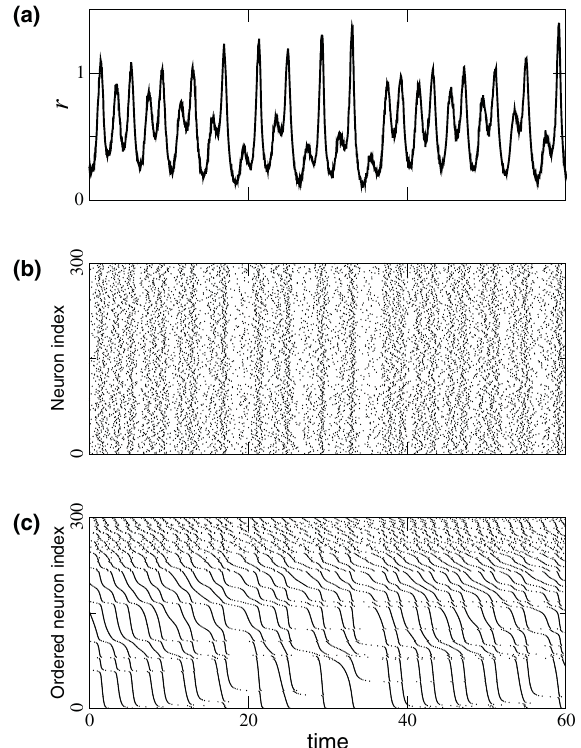
FIG. 7. Chaotic state in a network of N ¼ 10 4 QIF neurons with Gaussian-distributed currents. Network parameters correspond to the yellow triangle in the phase diagram of Fig. 5(b). As in Fig. 3, neurons receive a common periodic current I ð t Þ ¼ I 0 sin ð ω t Þ